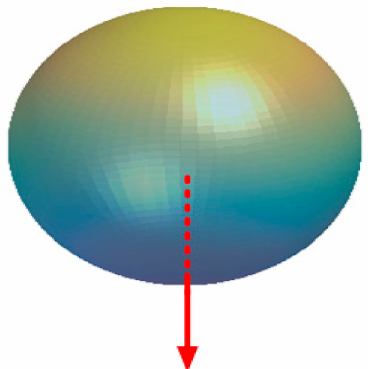
Figure 1. Three-dimensional spatial radiation characteristics of Lambertian optical